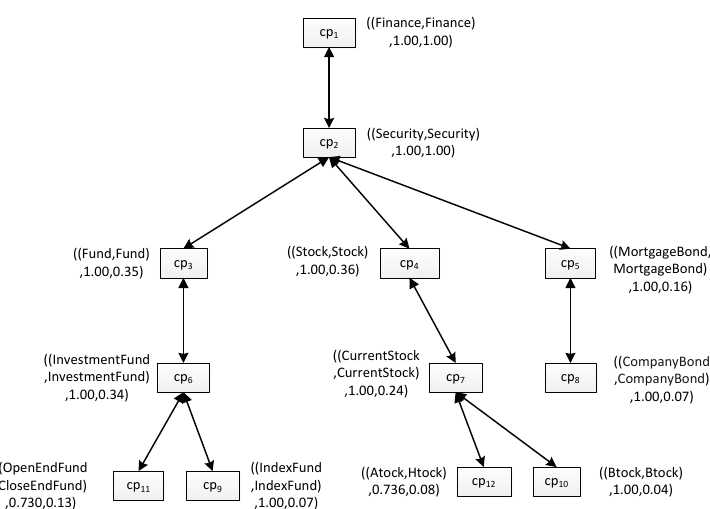
Figure 4. The matching tree between the user preference models of u a and u b .